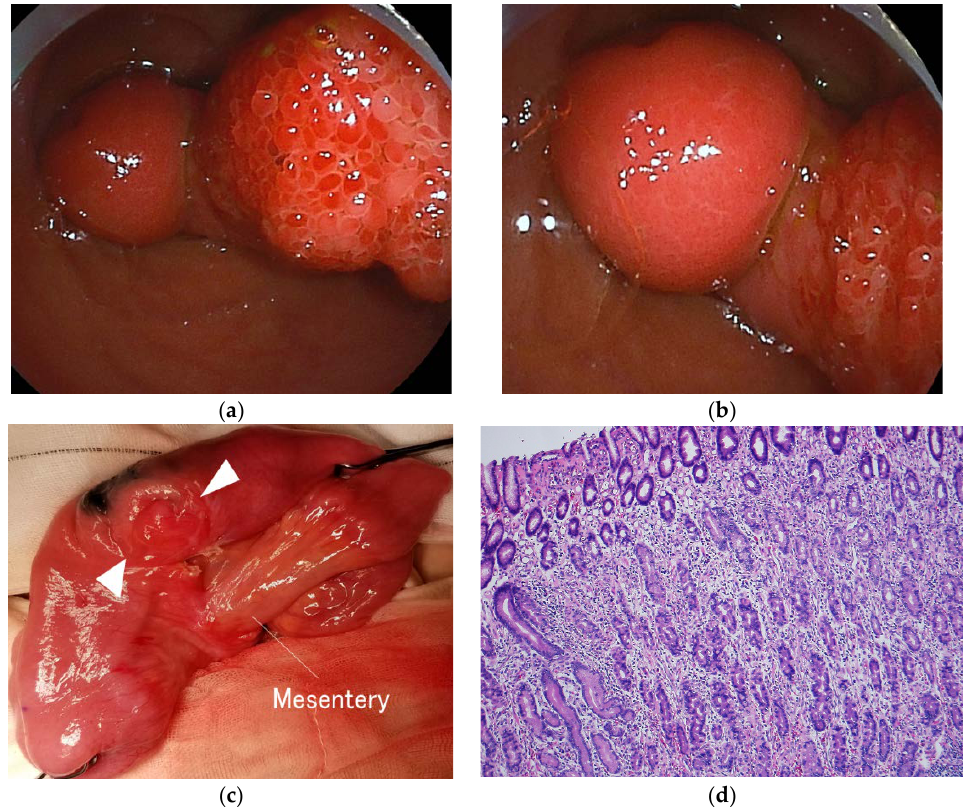
Figure 2. The endoscopic and histological findings of the inverted Meckel’s diverticulum. ( a ) Double-balloon endoscopy shows a pedunculated polyp-like structure; ( b ) A mass lesion is found at the tip of the polyp-like structure; ( c ) An inverted diverticulum (arrowhead) is found on the opposite side of the mesenteric attachment of the resected section; ( d ) Ectopic gastric mucosa is found on histological examination of the mass lesion at the tip (HE stain, ×100).